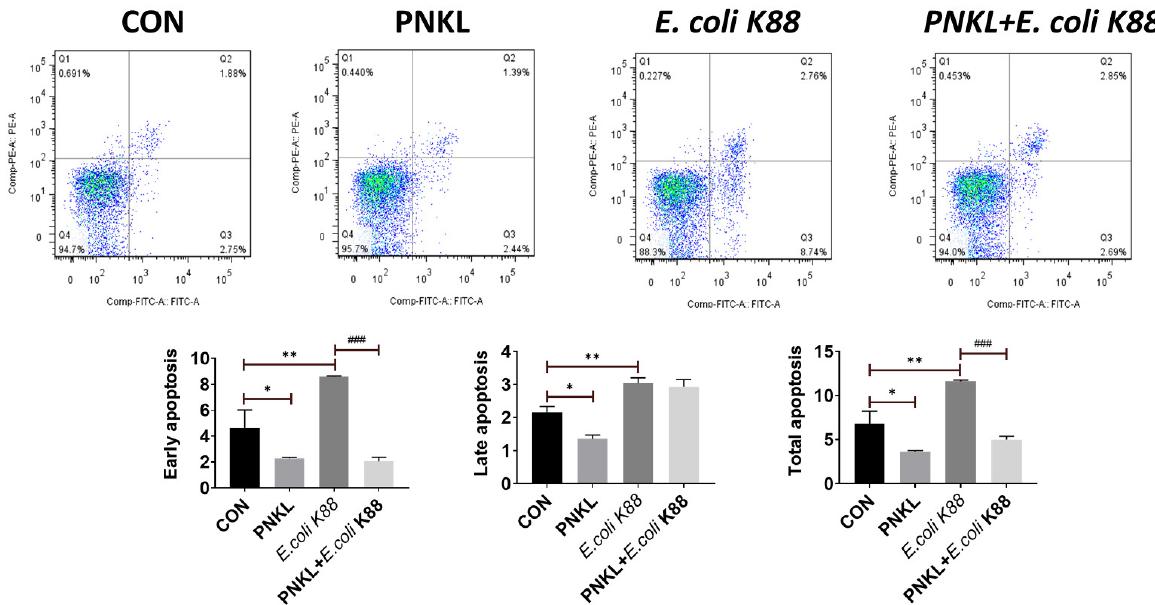
Figure 5. Influence of PNKL on E. coli K88-induced apoptosis in IPEC-J2 cells. Cell distribution analysis of apoptosis of IPEC-J2 cells treated with PNKL, E. coli K88, an PNKL plus E. coli K88. In each diagram, Q1 represents the percentage of non-viable, necrotic cells, Q2 represents the percentage of late apoptotic IPEC-J2 cells, Q3 represents the percentages of early apoptotic IPEC-J2 cells and Q4 represents the percentage of live IPEC-J2 cells. The statistical analysis of cell distribution data among samples, total apoptotic cells included Q2 with Q3. * Means significant difference compared with blank control group ( p < 0.05), ** Means significant difference compared with blank control group ( p < 0.01), ### Means significant difference compared with E. coli K88 control group ( p < 0.001).